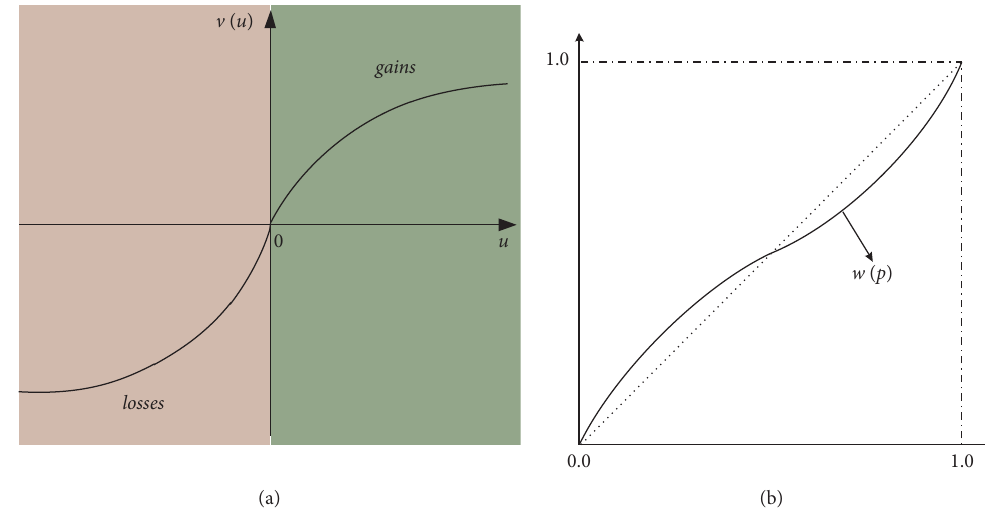
Figure 5: An example of (a) the value function and (b) the weighting function.